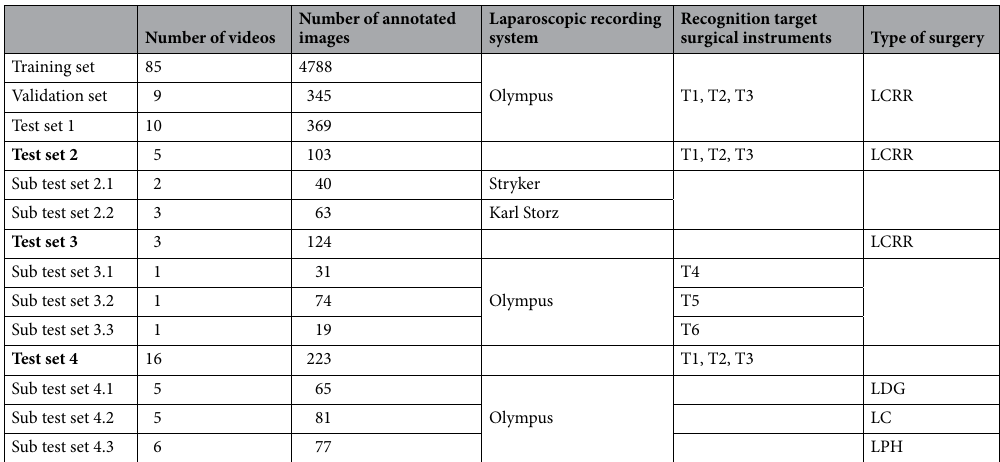
Number of annotated images